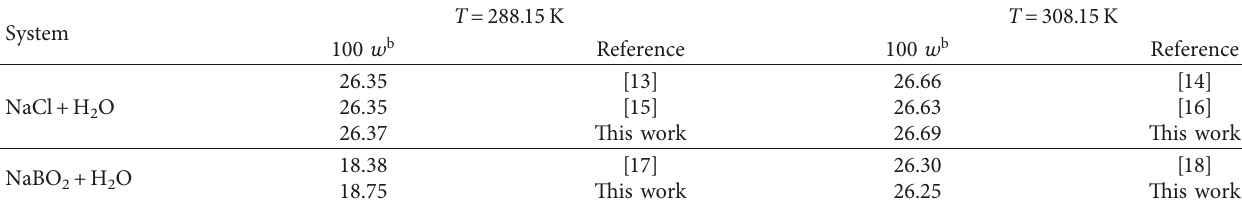
� 288.15 and 308.15K and p � 0 . 1 MPa. a 2 O) and (NaClO 3 +H 2 O) at T